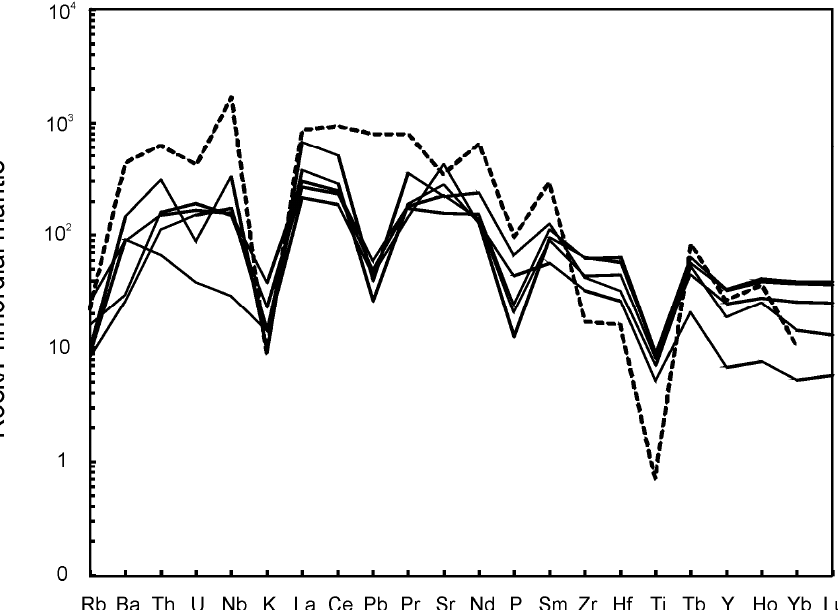
Figure 5. Mantle normalized incompatible elements patterns of silicocarbonatite from Breivikbotn occurrence. Curve for average carbonatite [32] is dotted and shown for reference. Primordial mantle composition is taken from [30].